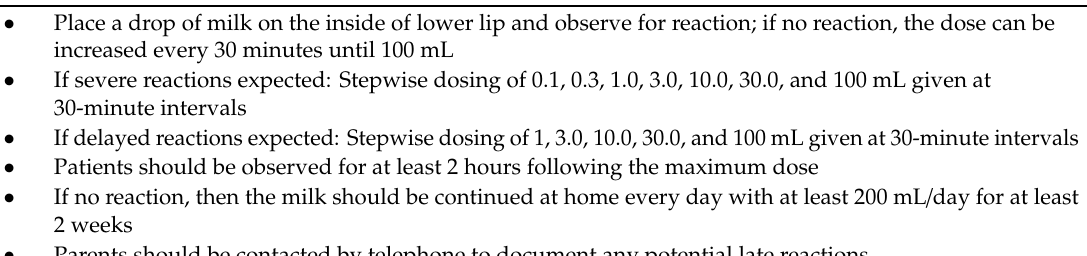
Table 4. Oral challenge protocol [7].